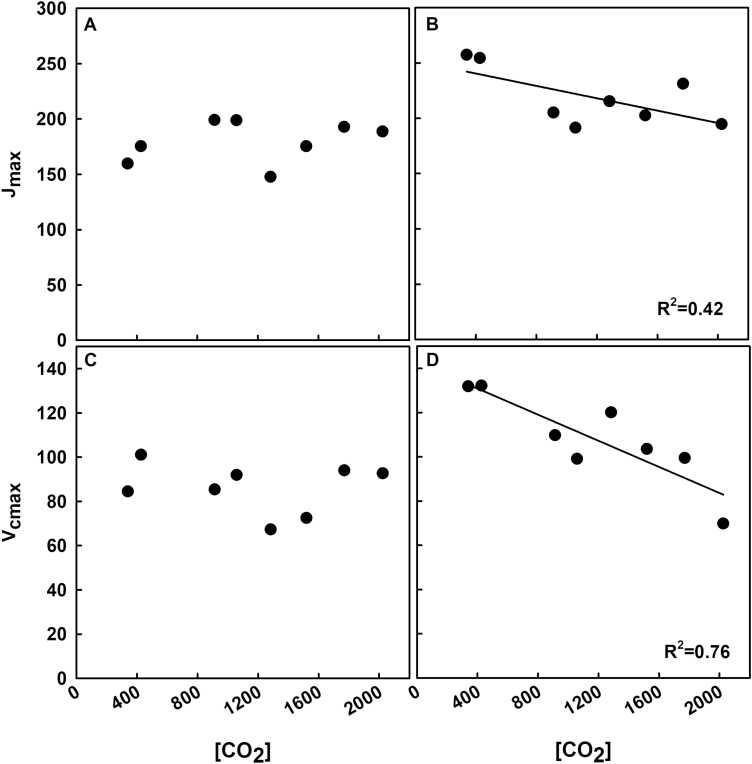

V
c,max and Jmax values as a function of [CO2]. Values were calculated from A/Ci measurements conducted on (A, C) 21 March (19 DAE) and (B, D) 5 April (34 DAE) using the PS-Fit model. Each point represents the average from each treatment. Statistically significant relationships (P<0.1) as a function of [CO2] are indicated by a fit plotted through the data. R2 values are indicated in the figure.